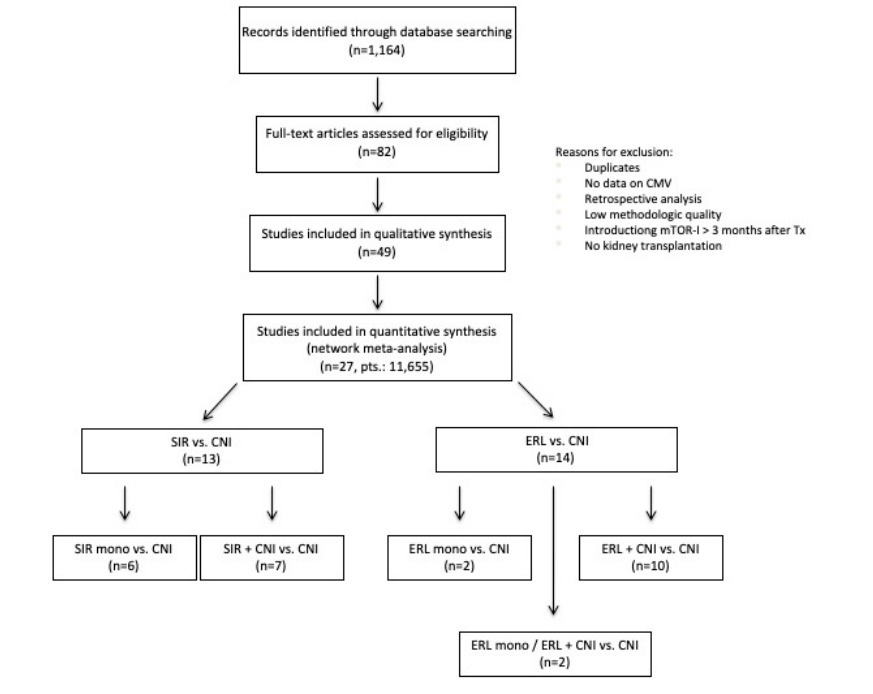
Figure 1. Flow chart of the selection of articles.